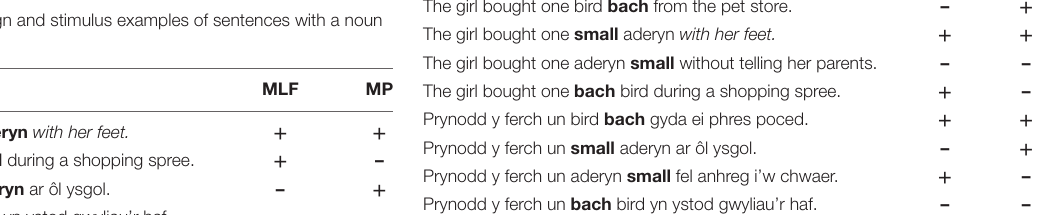
TABLE 5 | Experimental design and stimulus examples. The girl bought one bird bach from the pet store.